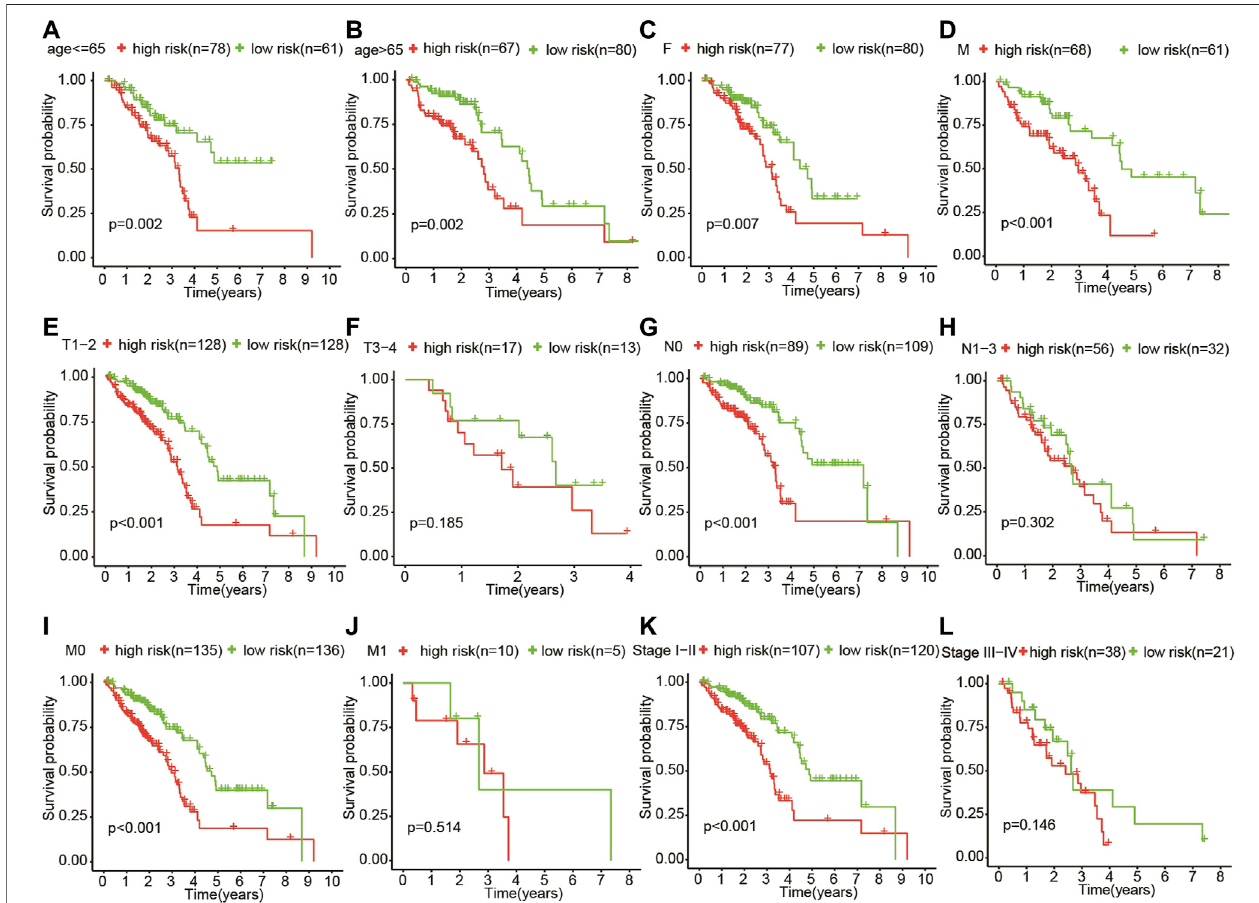
FIGURE 4 | Subgroup analysis showed that according to age ( A , B ), gender ( C , D ), TNM stage ( E – K ), and clinical stage ( L , M ), the OS of patients in the high-risk group was more unfavorable than that in the other